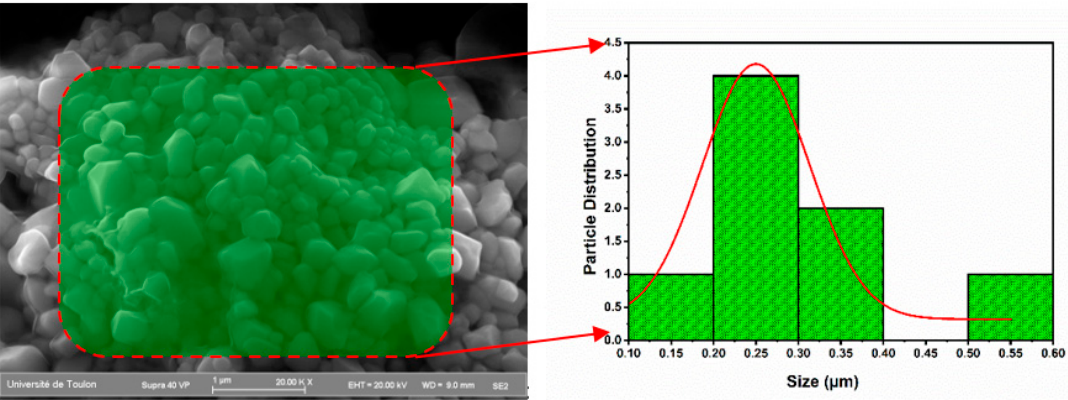
Figure 8. ( a ) Absorption spectrum of RhB in the presence of BiP particles and in the absence of UV irradiation; ( b ) photocatalytic degradation of RhB dye under UV light irradiation in the absence of the catalyst.